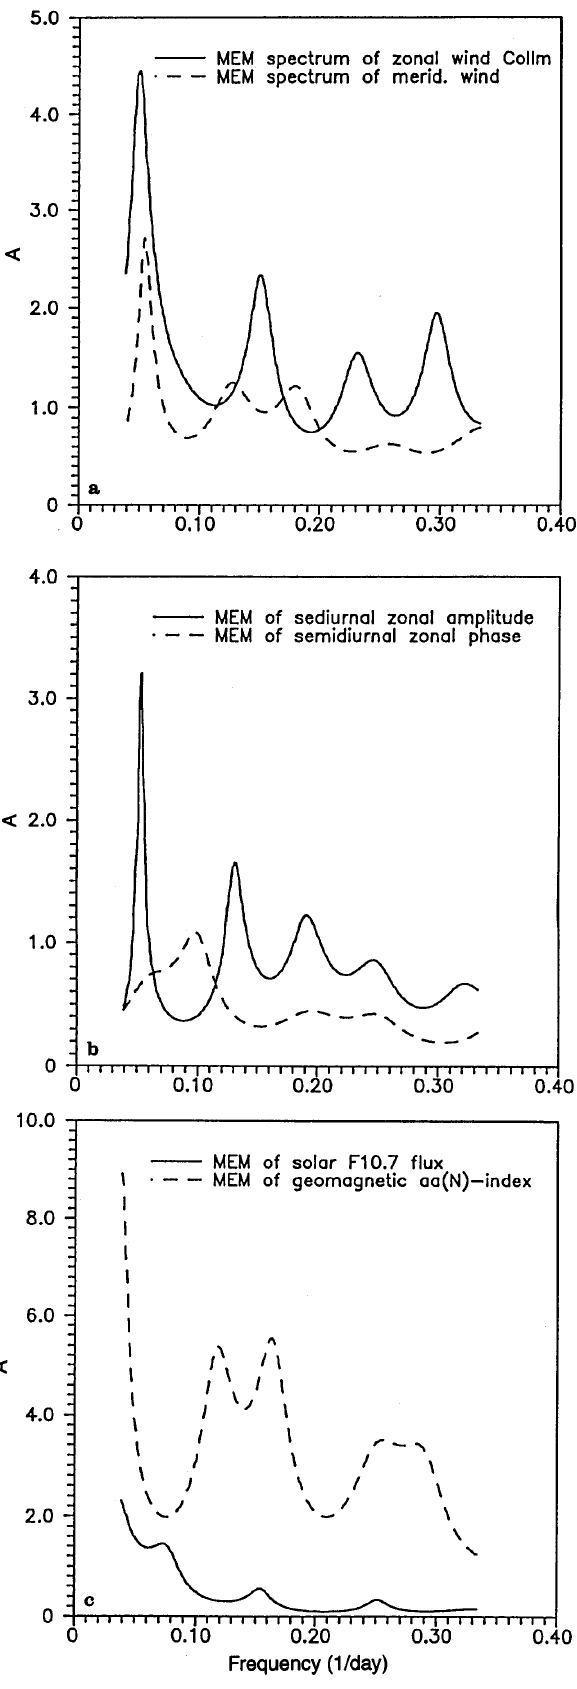
Fig. 7. MEM spectra in the period interval 3–25 days for a zonal ( solid line ) and meridional ( dashed line ) neutral wind measured at Collm, b amplitudes ( solid line ) and phases ( dashed line ) of the semidiurnal tide in zonal wind, and c solar radio flux F10.7 ( solid line ) and geomagnetic aa ( N )-index ( dashed line )